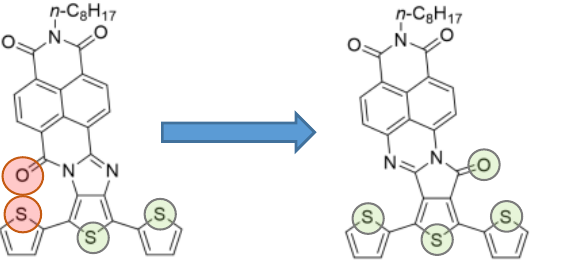
Figure 8. Illustration of the oxygen–sulfur interaction in NDI-3T and NAI-3T derivatives. As it is depicted in Scheme 5, for the syntheses of the NAI derivatives, naphthalimide moieties endowed with amino functionalities ( 11 ) and a thiophene derivative endowed with anhydride functionality ( 12 ) were used as starting materials.